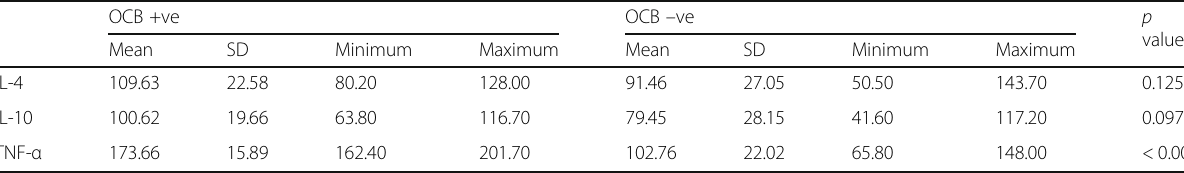
Table 2 Comparison of levels of IL-4, IL-10, and TNF- α in OCB +ve and – ve patients OCB +ve OCB –